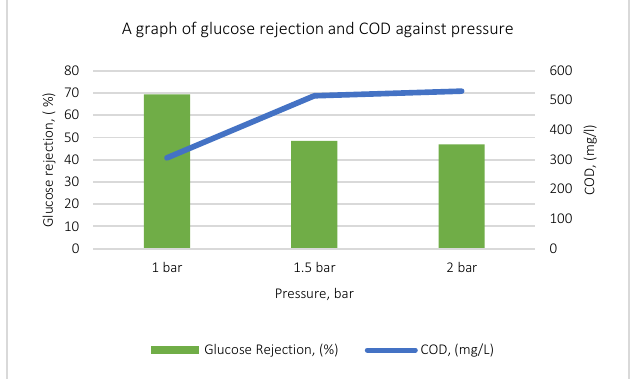
Figure 4: Glucose rejection and COD rejection of PVDF/e-TiO2-1 bar, PVDF/e-TiO2- 1.5 bar and PVDF/e-TiO2-2